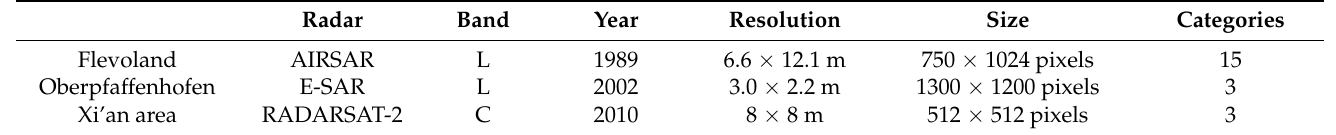
Table 4. Information on three PolSAR data